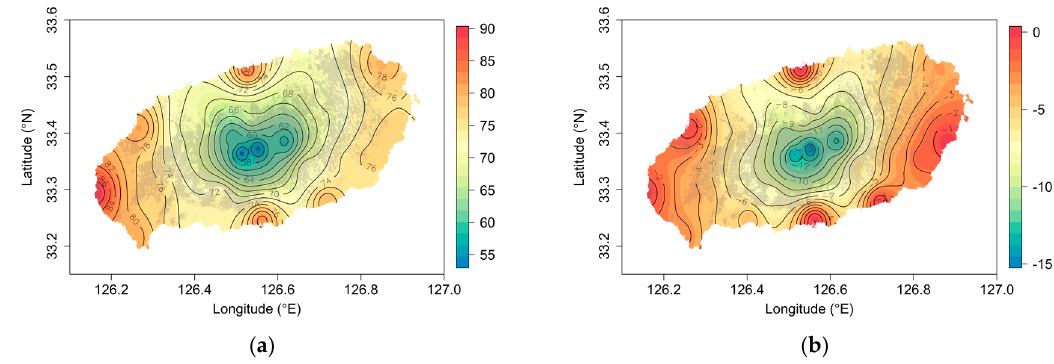
Figure 5. Spatial distribution of ( a ) annual average monthly ET 0 (mm/day) of EXT and ( b ) the difference between EXT and OBS (EXT-OBS). The shaded region represents the forest area (refer to Figure 1b). The meteorological data maps (Figure 4a) show the generally expected spatial